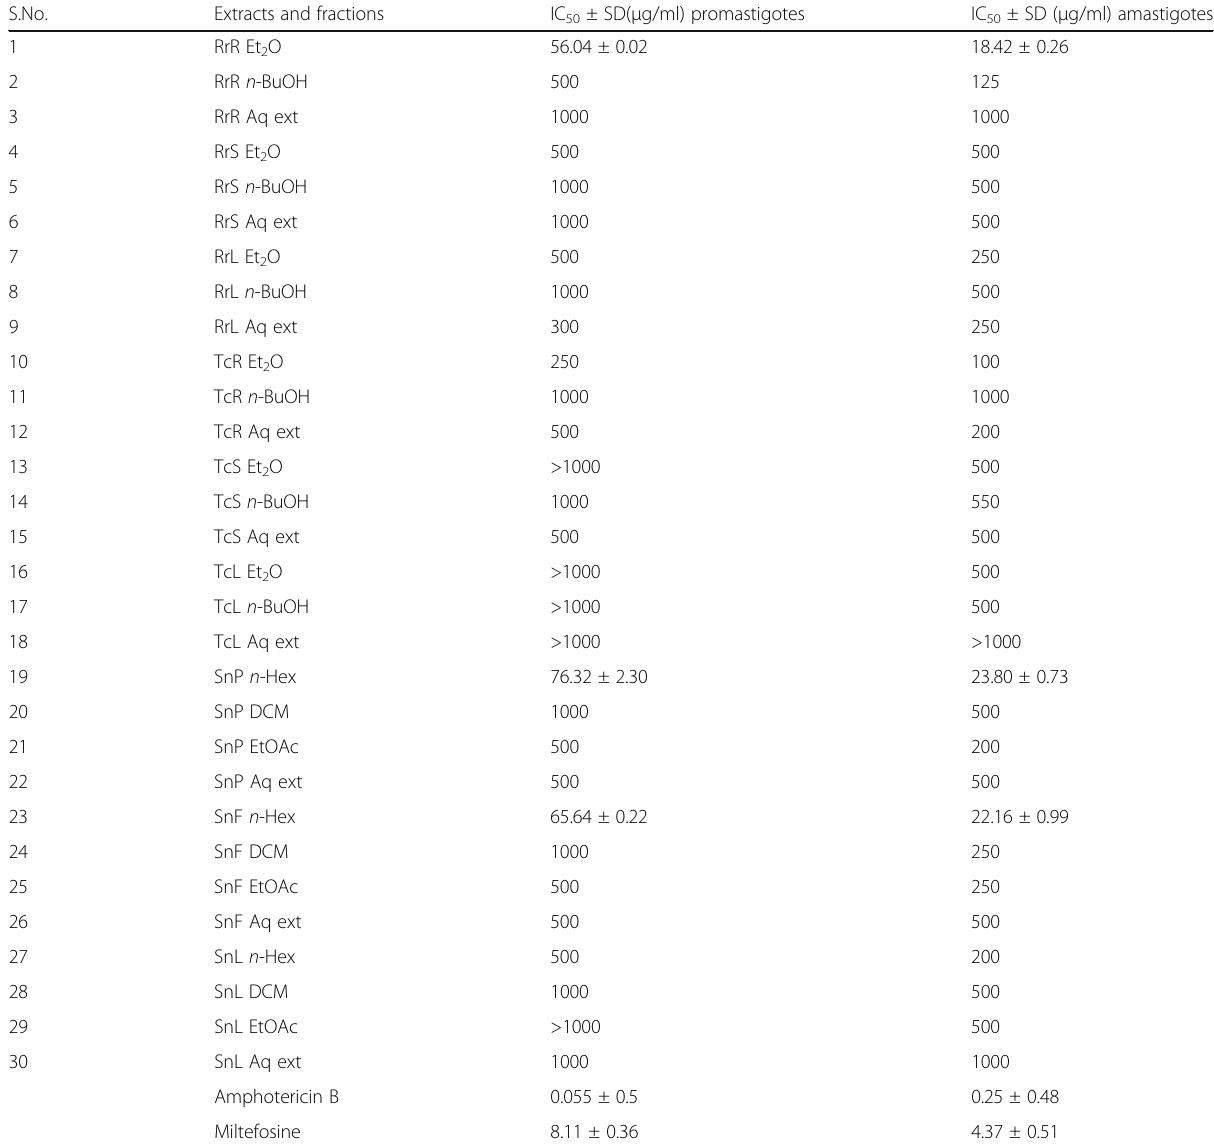
Table 5 In vitro leishmanicidal activity against promastigotes and intracellular amastigotes of L. donovani